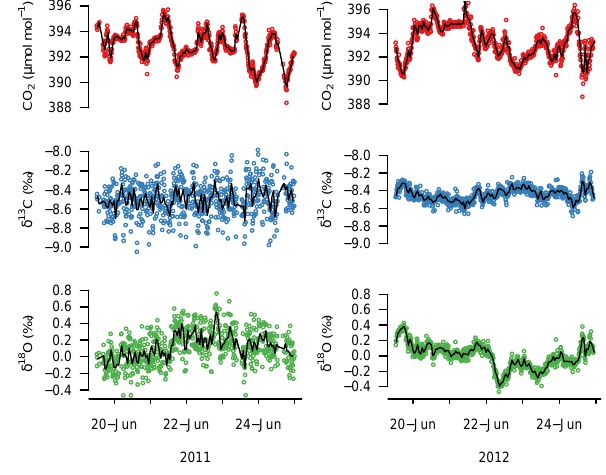
Fig. 3. Comparison of 10min averaged data for six days in June 2011 and 2012, i.e., before and after the instrument upgrades. The solid lines are the 1h averaged